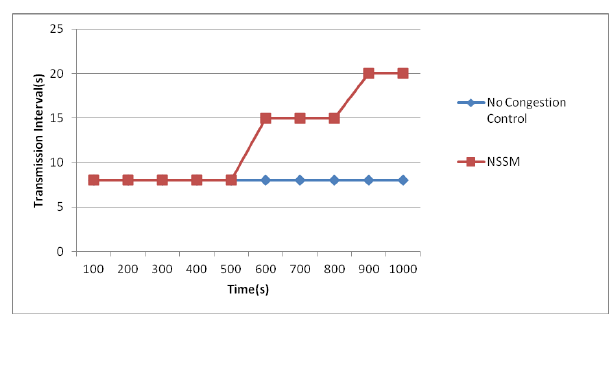
Figure 6. Traffic Control at node